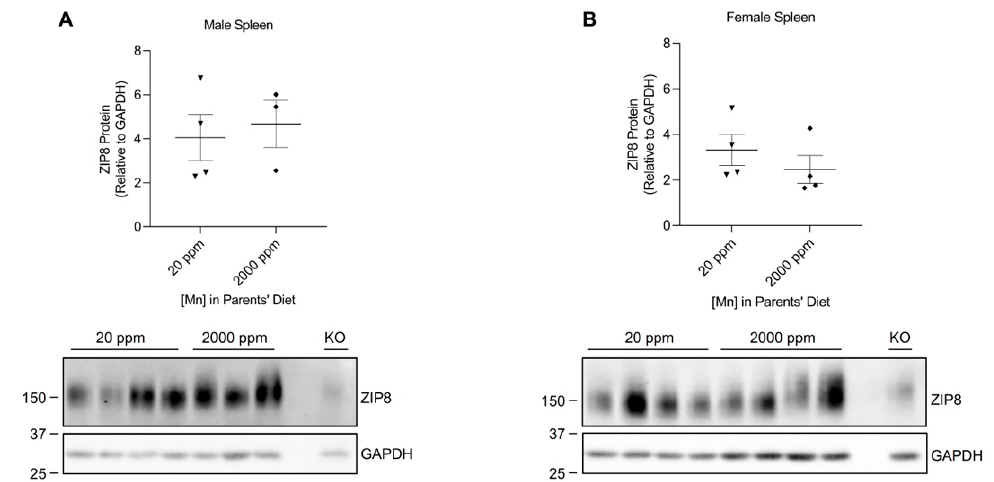
Figure 4. Comparison of spleen ZIP8 levels between the control and high-manganese diet groups. Spleen samples were collected from pups at 3 weeks of age. ZIP8 in male ( A ) and female ( B ) pups that were born from and fed by mothers on 20 ppm manganese and 2000 ppm manganese diets were analyzed by Western blot analyses ( n = 3–4/group). Samples with equal amounts of protein (124 µg) were assessed. Blots include the spleen sample from a female, 6-week-old Zip8 -KO mouse (fed a traditional rodent diet) as a control. Quantification of ZIP8 levels were determined using GAPDH as the loading control. Data are expressed as mean ± SEM.